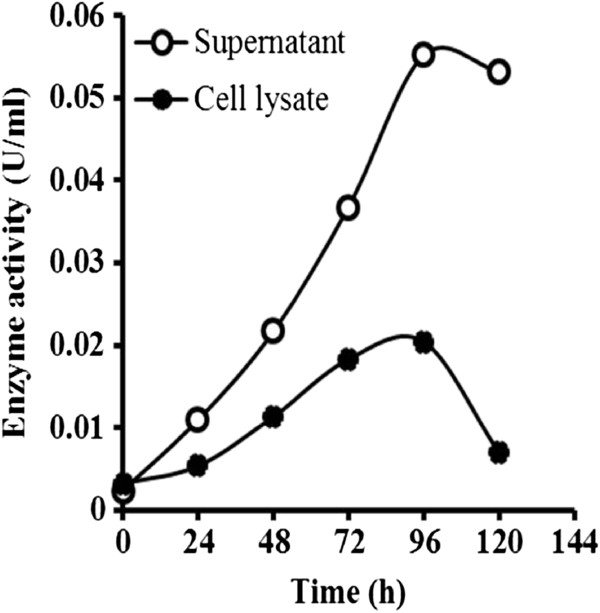
Induction and expression of α-glucosidase activity. α-Glucosidase activity levels (assumed to be from the rAciHBGase II-(His)6 enzyme) in the culture medium (supernatant) and P. pastoris cell lysate after being induced by 0.5% (v/v) MeOH in 50 ml cultures.